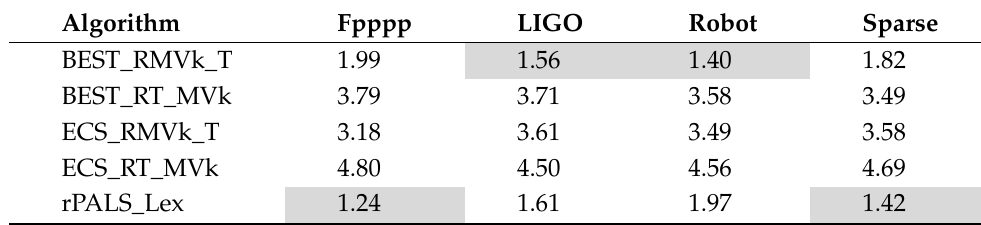
Table 18. Energy Friedman rankings